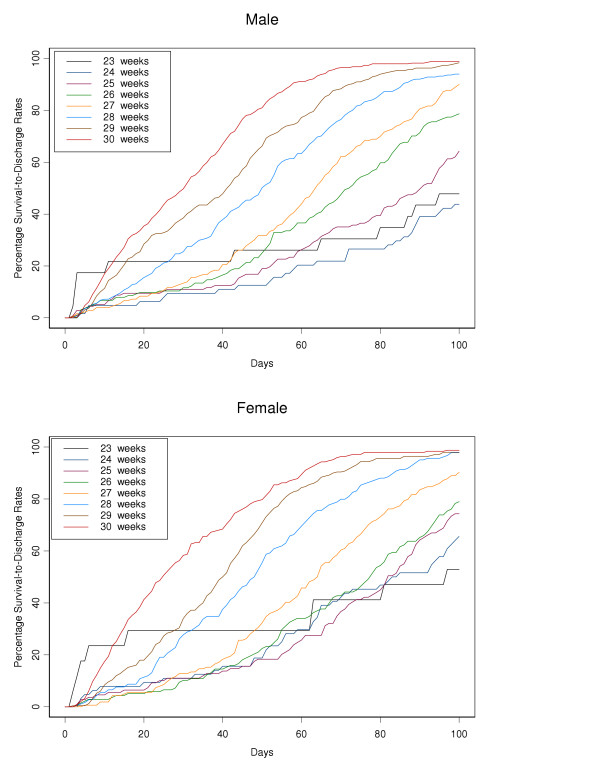
Probability of survival to discharge (y-axis), for male and female infants surviving to a given day in the NICU (x-axis), stratified by gestation age.